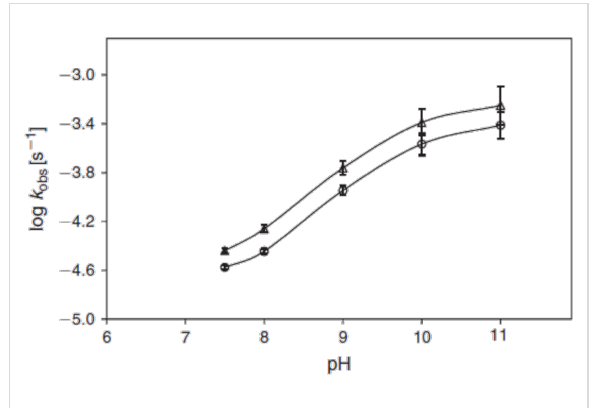
Figure 4: log k –pH profiles for the photolysis of FMF (10 − 4 M) in alka- line solution under aerobic ( ○ ) and anaerobic ( ∆ ) conditions irradiated for 1 h at 25 ± 1 °C using a Philips 25 W fluorescent lamp (emission at 405 and 435 nm, intensity 4.52 ± 0.15 × 10 16 quanta s − 1 ). Repro- duced with permission from [32]. Copyright 2013 CSIRO Publishing.